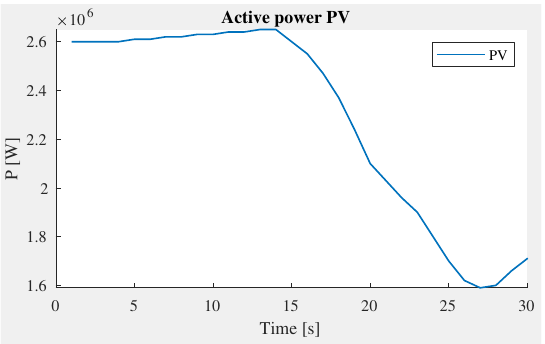
Figure 14. Active power